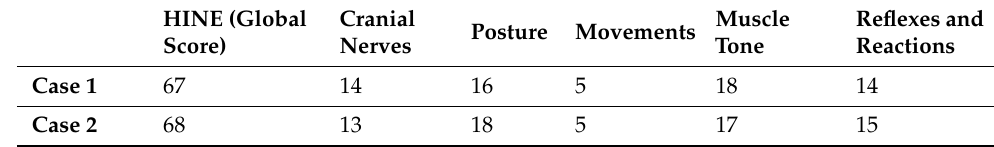
Table 1. Hammersmith Infant Neurological Examinations (HINE) of case